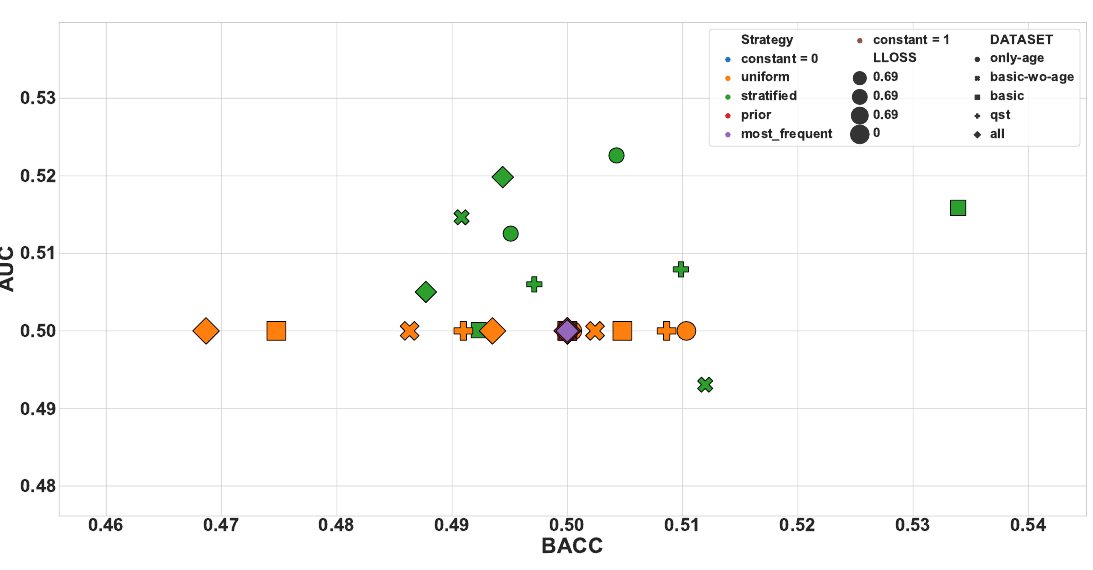
Figure 2. Baseline based on dummy